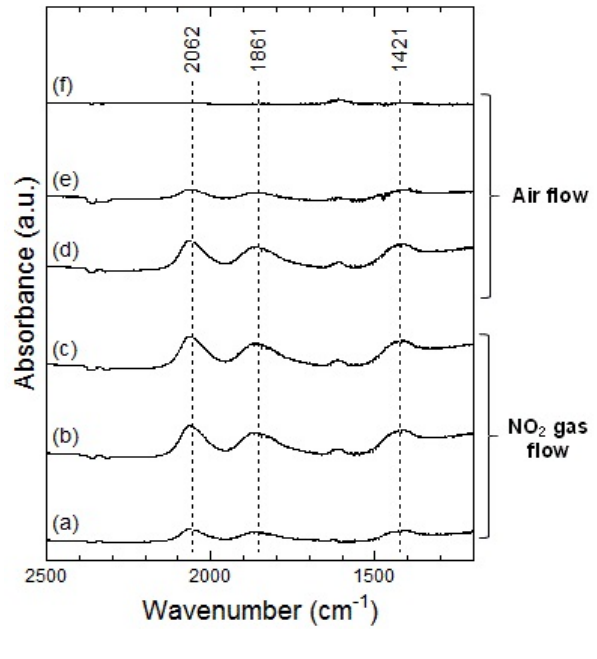
powder at 200 °C. The powders were exposed to 1 ppm Figure 8. DRIFT spectra of WO 3 in air for ( a ) 2 min, ( b ) 20 min, and ( c ) 50 min. After NO of NO 2 were purged by air for ( d ) 1 min, ( e ) 30 min, and ( f ) 60